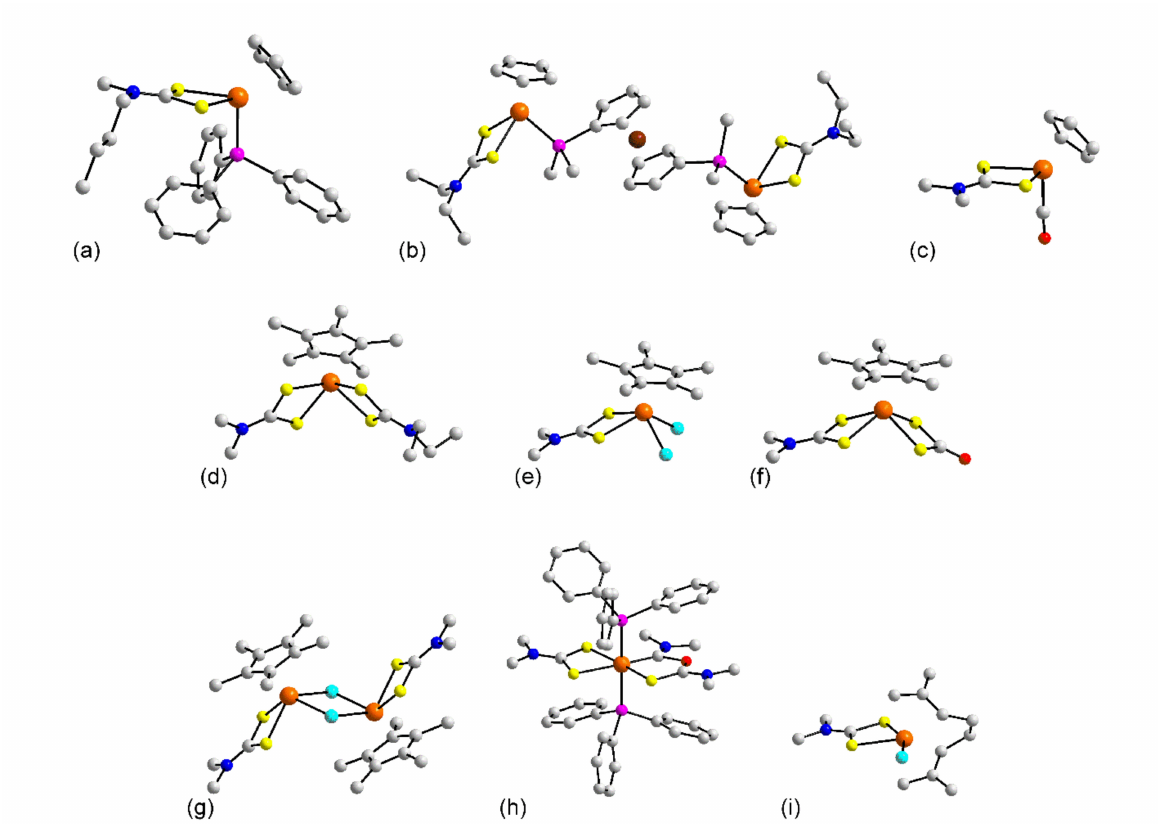
Figure 5. Molecular structures of ruthenium complexes: ( a ) CpRu(PPh 3 )( L 11 ) ( 50 ), ( b ) {[CpRu( L 24 )] 2 (dppf)} in the crystal of 54 , ( c ) CpRu( L 8 )(CO) ( 55 ), ( d ) [Cp*Ru( L 8 )( L 24 )] + in 57 , ( e ) Cp*Ru( L 8 )Cl 2 ( 58 ), ( f ) Cp*Ru(S 2 C=O)( L 8 ) ( 60 ), ( g ) [Cp*Ru( L 8 )Cl] 22+ in 64 , ( h ) [(PPh 3 ) 2 Ru(C(NMe 2 )OC(NMe 2 )=S)( L 8 )] + in 67 , and ( i ) Ru(X 1 )( L 8 )Cl ( 69 ). In ( b ), only the ispo-C atoms of the phosphane bound phenyl rings are shown for